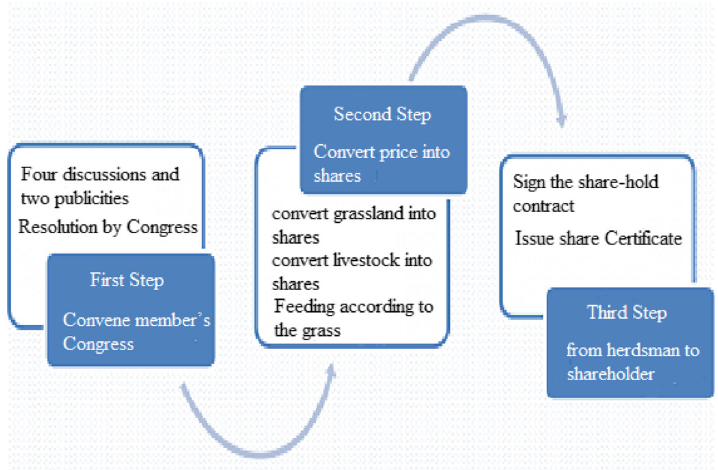
Fig. 2 The Conversion of the Means of Production into Shares. Source: Personal interviews and minutes of the